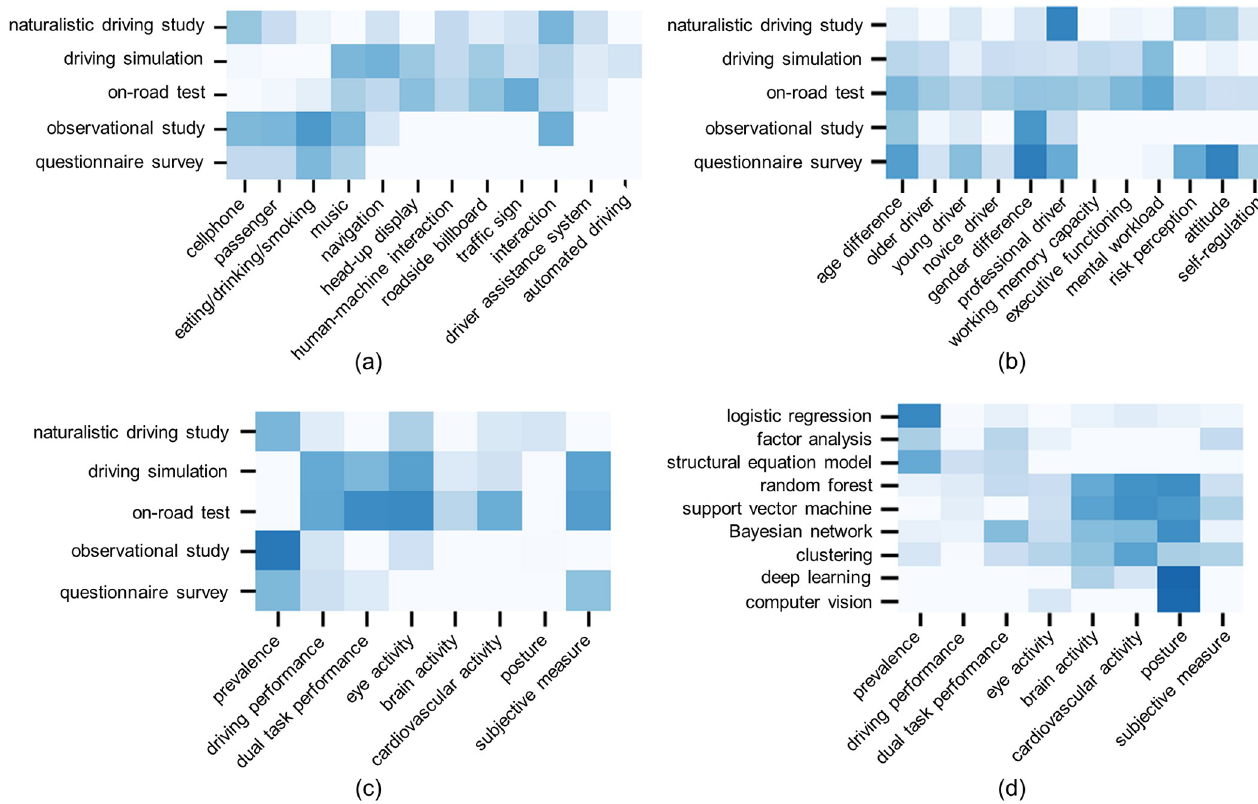
Fig 9. Visualization of the relationships between related